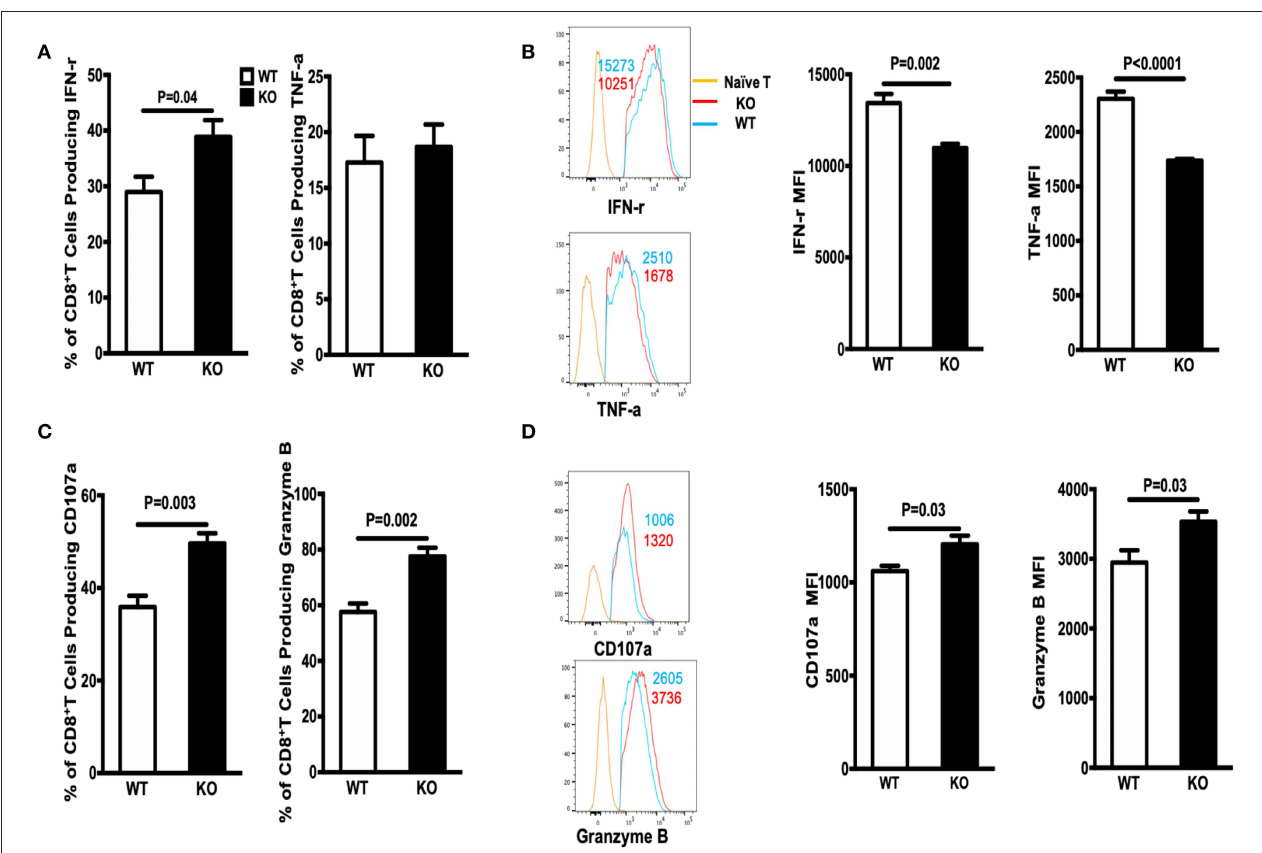
FIGURE 2 | Cytokine production by WASp − / − mice is altered during the expansion stage. Cytokine production was analyzed by flow cytometry after re-stimulation of in vivo -primed (Day 8) virus-specific T cells for 5h. (A) The percentages of IFN- γ + cells (left panel) or TNF- α + cells (right panel) within the CD8 + T cell population in the spleen. (B) Representative data of IFN- γ expression (left upper panel, gated on Live CD8 + CD44 + IFN- γ + cells) and TNF- α expression (left lower panel, gated on Live CD8 + CD44 + TNF- α + cells); the numbers in the histograms represent the MFI for the indicated protein, naïve T cell were used as a negative control. (C) The percentages of CD107 α - and Granzyme B-producing cells within the CD8 + T cell population. (D) representative data of CD107 α expression (left upper panel, gated on Live CD8 + CD44 + CD107 α + cells) and Granzyme B expression by Granzyme B + CD8 + T cells (left lower panel, gated on Live CD8 + CD44 + Granzyme B + cells), the numbers in the histograms represent the MFI for the indicated protein, naive T cell were used as a negative control. Data are expressed as the mean ± SEM, each with 5 mice per group. Data were analyzed using an unpaired t